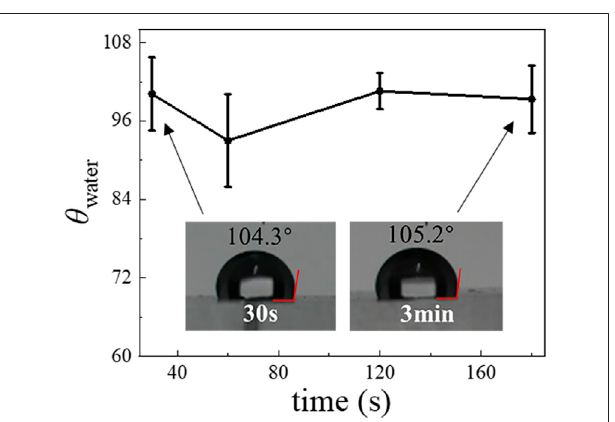
FIGURE 8 | The θ water of PDMS surface with different PFDTES — treatment time.